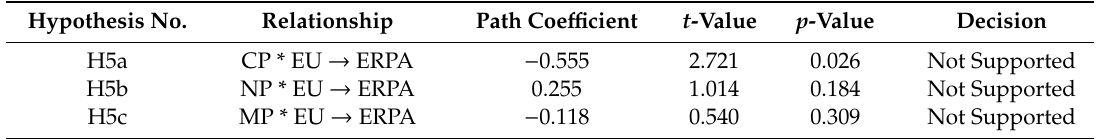
Table 5. Results of moderation relationship